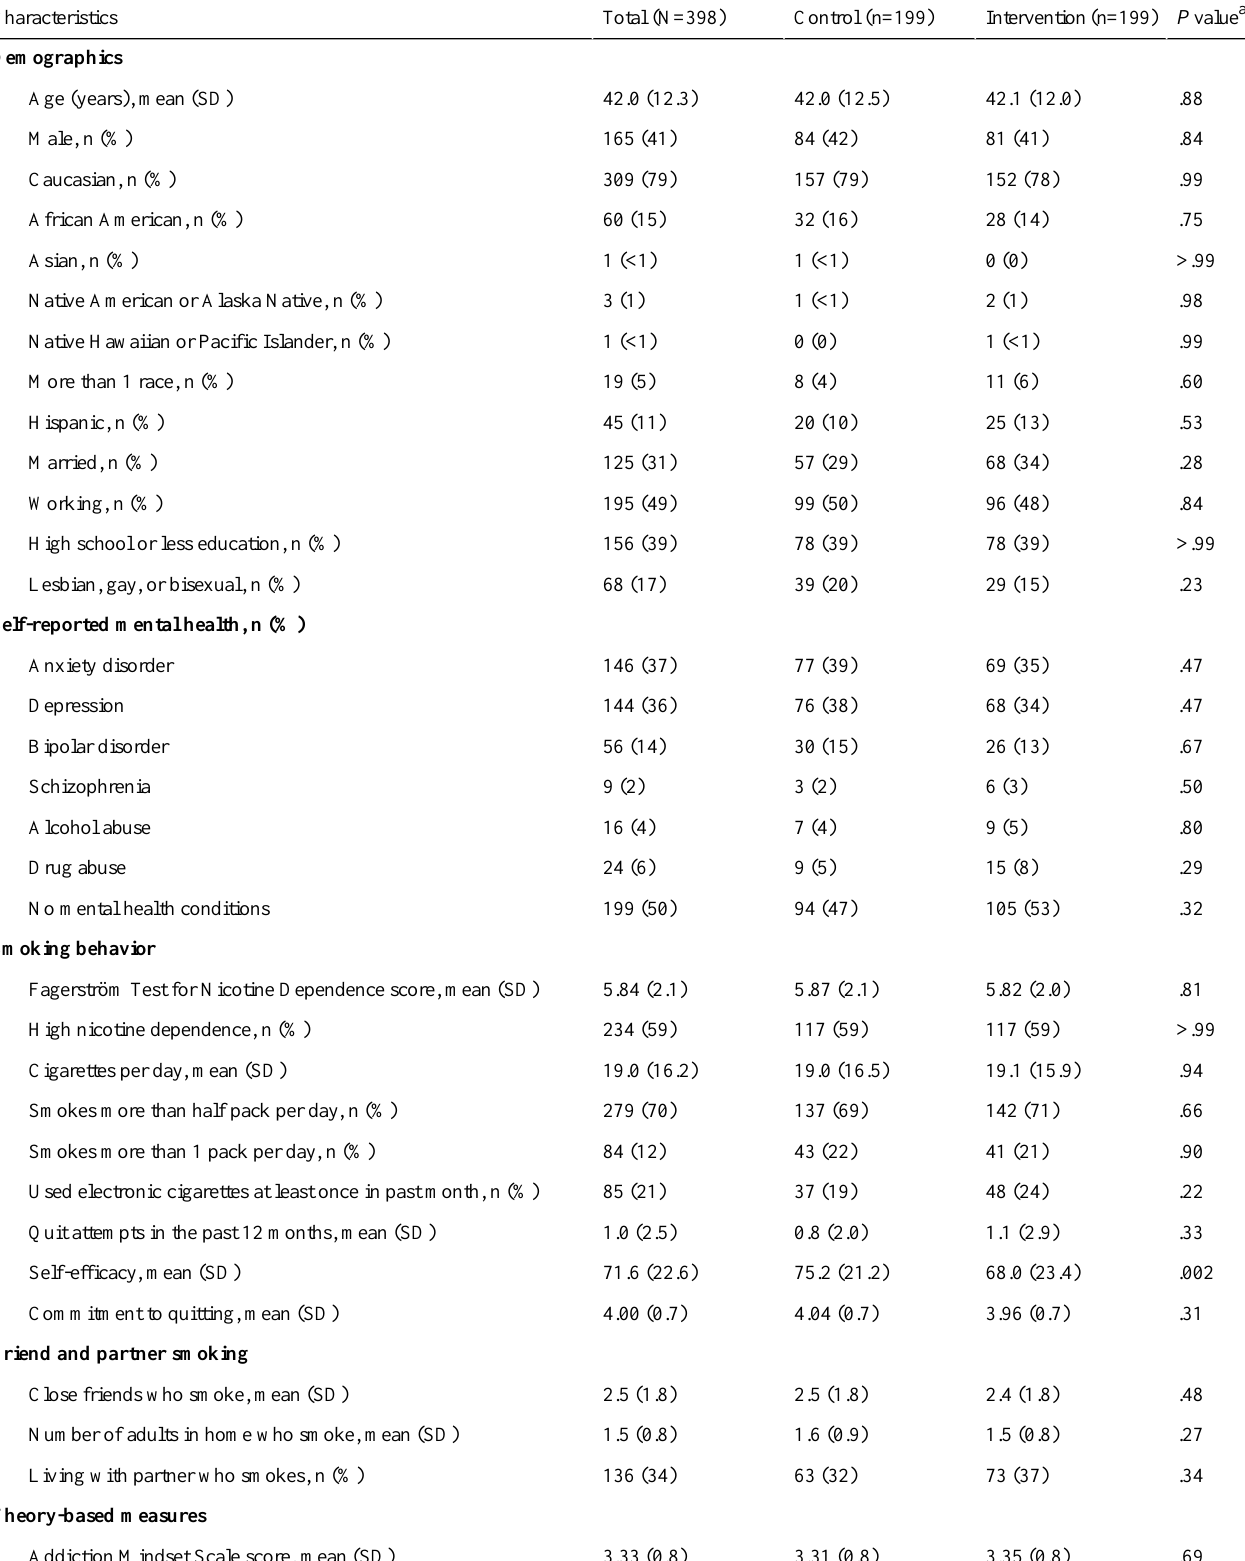
Table 1. Baseline demographics, self-reported mental health, smoking history, and behavior of participants in the Mindset Intervention for Nicotine Dependence study for the intention-to-treat